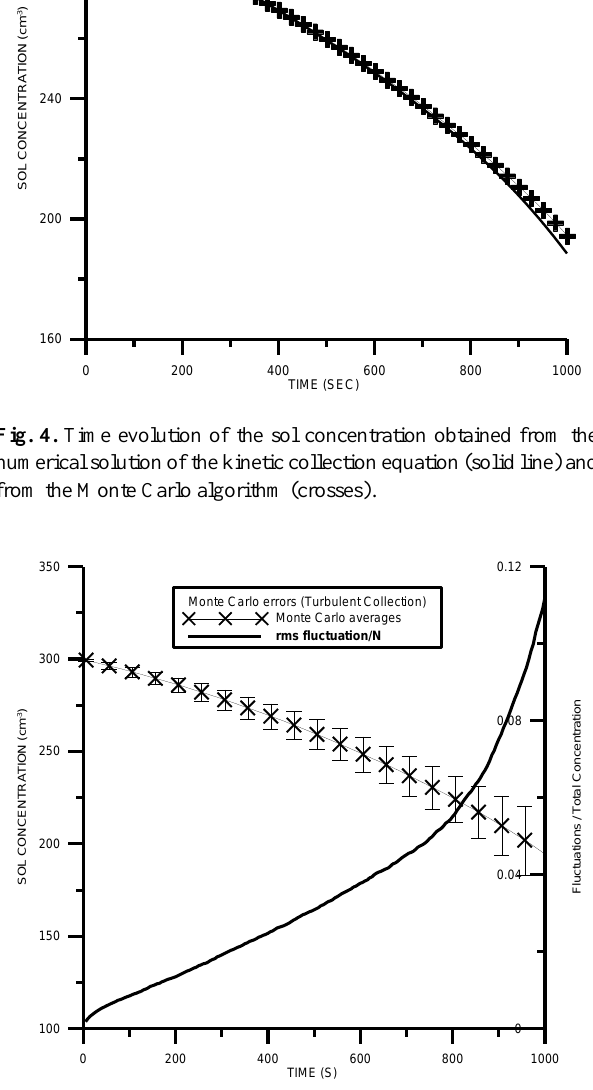
Fig. 5. Time evolution of the sol concentration obtained from Monte Carlo algorithm (crosses and left axis) fluctuations about the average (vertical bars and left axis) and the ratio ( ( )) ( ) N t N t (solid line and right axis).